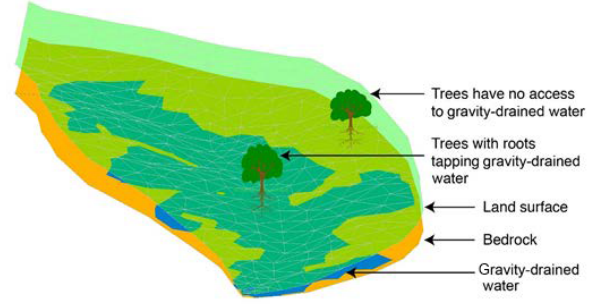
Figure 5. A schematic diagram showing how connectivity of a land- scape might affect the distribution of water that is drained by grav- ity or held in the matrix. Gravity-drained water enters as rainfall, drains vertically through the unsaturated zone to the groundwater, and leaves the watershed. Under this scenario, roots of trees high in the catchment do not access this water (except ephemerally dur- ing drainage), and instead may rely predominantly on matrix water. These trees may not have roots that reach the groundwater because of the thickness of the unsaturated zone and weathered material high in the landscape. By contrast, roots of trees in the channel or swales may access gravity-drained and matrix water as well as the bedrock interface and groundwater. This diagram emphasizes that trees high in the watershed may not interact with the stream because of low connectivity. In contrast to this conceptual picture, many watersheds may have intermittent connectivity between trees high in the catch- ment and the stream because of transient saturation at the bottom of the rooting zone or at the interface of mobile soil and the underlying weathered immobile material. Such transient perched water tables may allow down-hillslope flow of water from the ridgetops to the stream, providing intermittent connectivity (see hypothesis